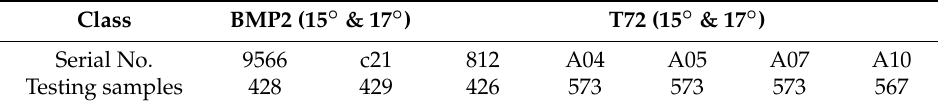
Table 9. Dataset of EOC-2 (configuration